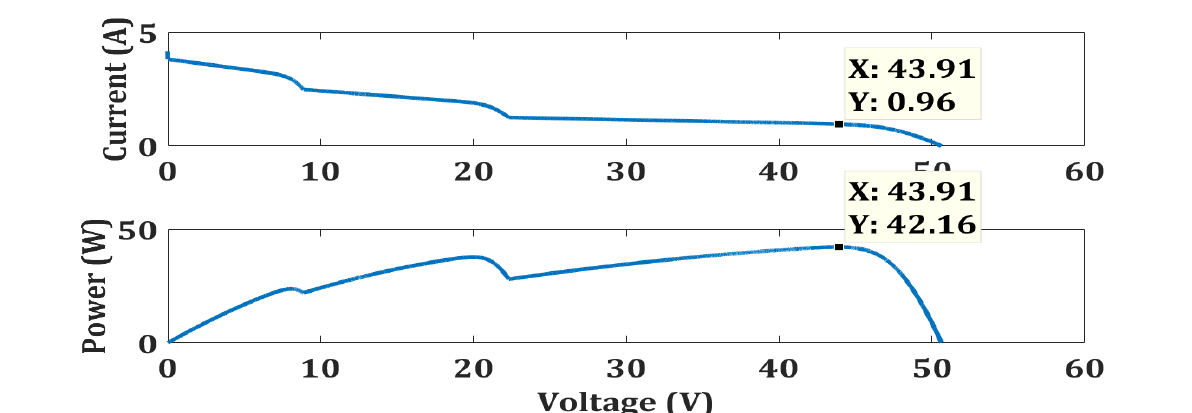
Fig. 9. Performance Comparison of FPA and AFPA in Weak Partial Shading